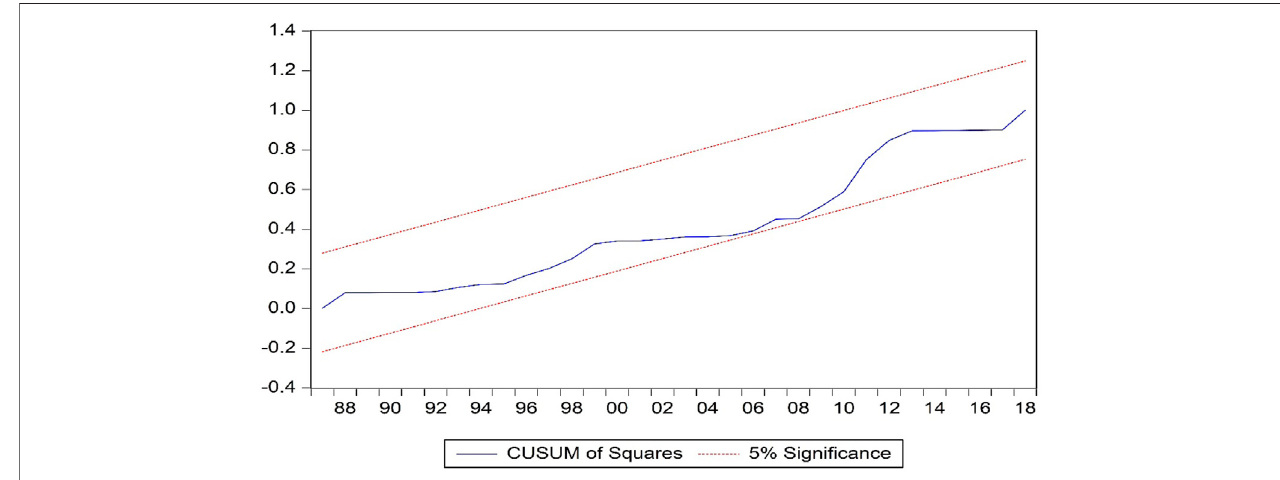
FIGURE 8 | CUSUMsq plot (model 2).